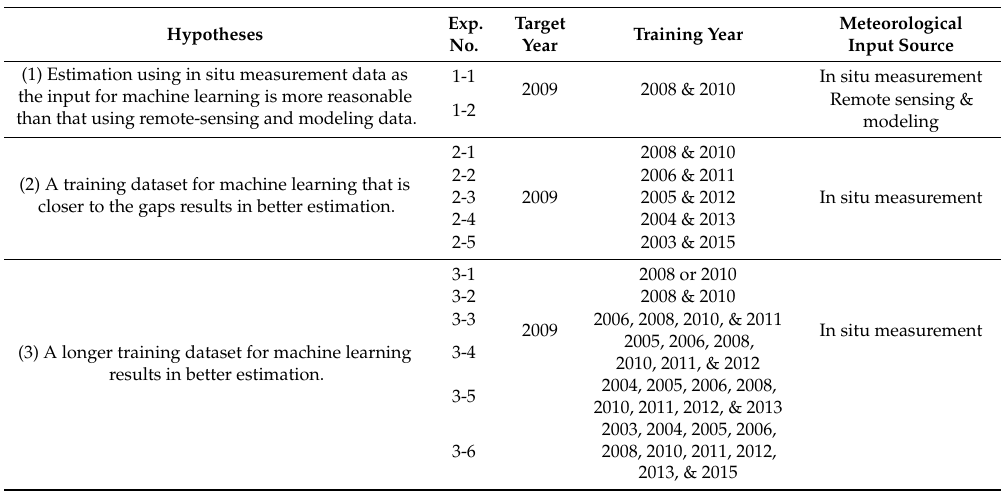
Table 3. Hypotheses and experimental